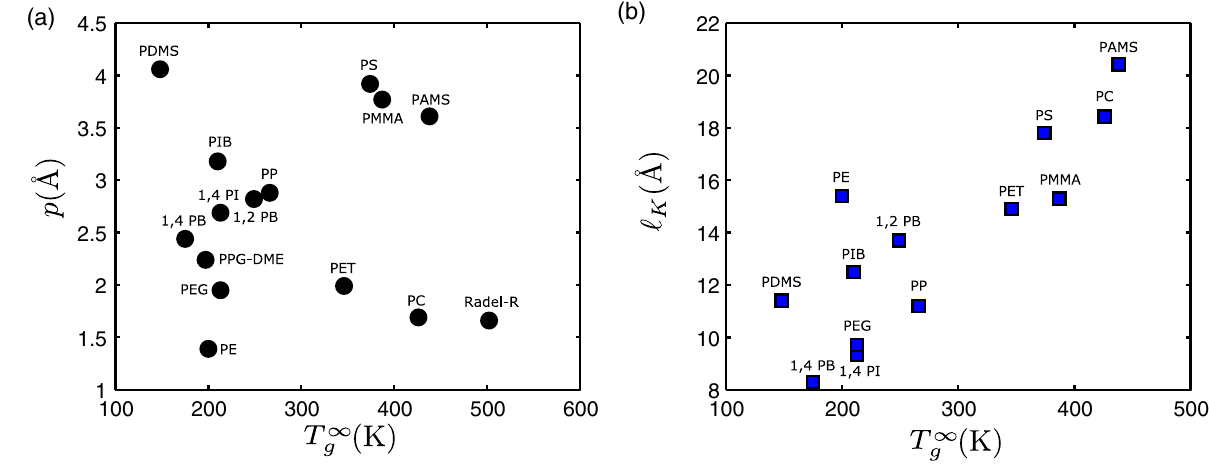
FIG. 14. Relation between T ∞ and the packing length p and the Kuhn step l g PS, PAMS, PC, Radel-R (only p ), PEG, PPG-DME (only p ), and